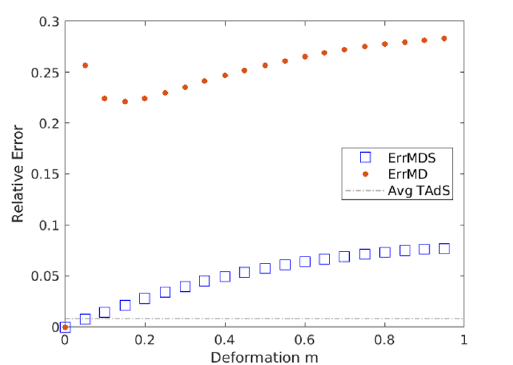
Figure 13 (a). A histogram of relative errors from different boundary data: Thermal AdS (TAdS), global mass deformation (MD), local quench without smoothing (LQ), and system with random disorder (Disorder). Boundary rel- ative error E bdy plotted on the x -axis.